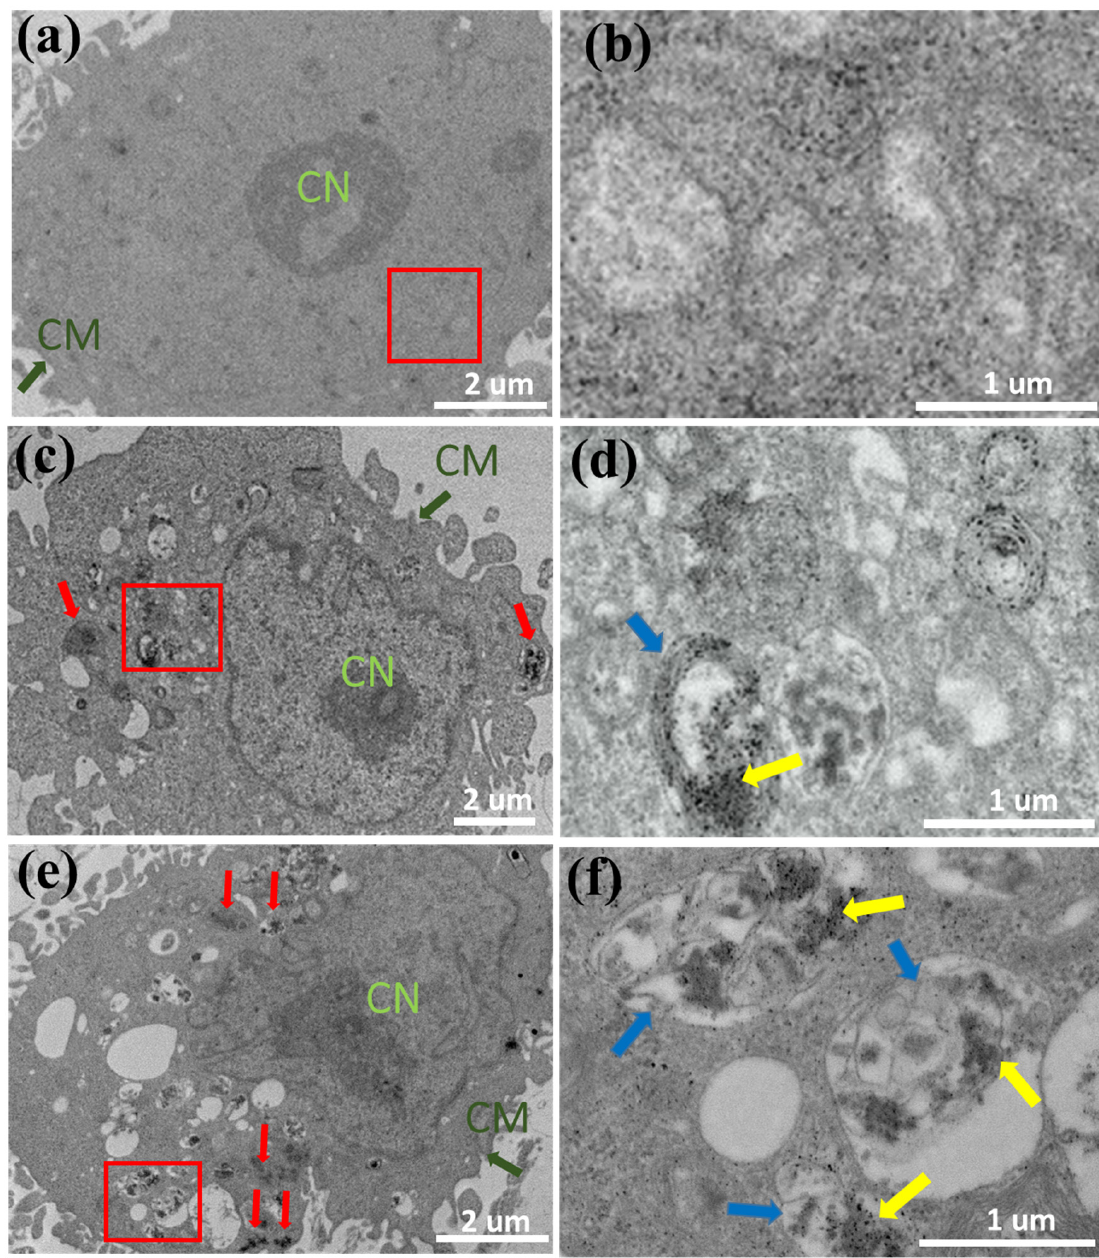
Figure 5. Cross-section of TEM images of multifunctional silicon NPs in the endosome and mito- chondria in HeLa cells, with the magnified TEM images of red square boxes ( a , b ) Control MPSi; ( c , d ) FMPSi-Cis@GO; and ( e , f ) FMPSi-Cis@GO@DQA. HeLa cells were treated with 50 μ g/mL NPs. CM and CN represent cell membrane and cell nucleus, respectively. Red and yellow arrows indicate NPs, and blue arrows indicate mitochondria.